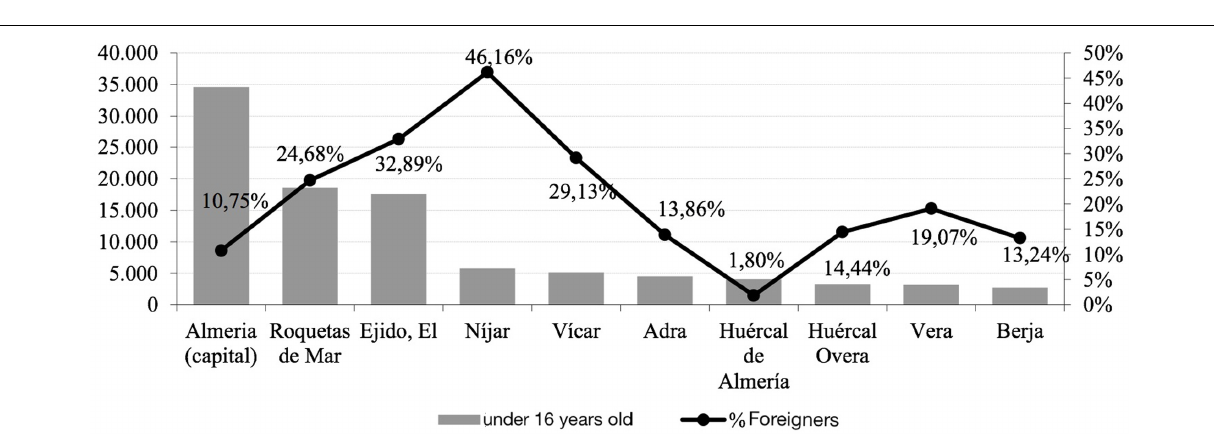
of racial harassment stigma among young people under 16 years.